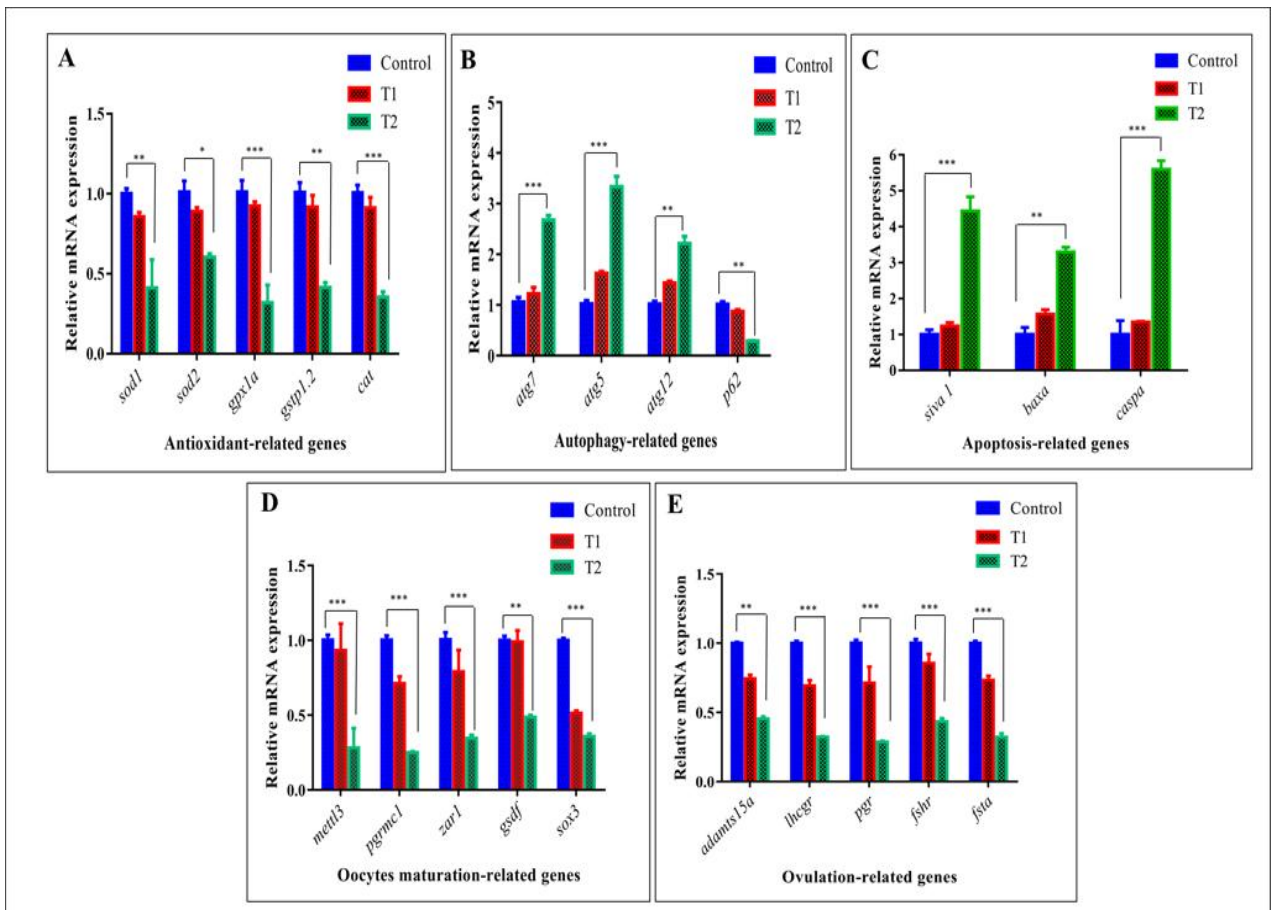
Figure 7. Effect of ZnO-NPs on oocyte maturation and ovulation via the induction of oxidative stress and the apoptotic pathway at the genetic level. ( A – C ) Expressions of mRNA evaluated by qRT-PCR indicate the downregulation of antioxidant-related genes in T2 ( A ), the upregulation of autophagy- related genes in T2 ( B ), and the induction of apoptosis-related genes in T2 ( C ). ( D , E ) mRNA expres- sion shows the downregulation of oocyte maturation-related genes in T2 ( D ) and ovulation genes in T2 ( E ). The results from three dependent experiments are shown as the mean ± SEM. * p < 0.05, ** p < 0.01, *** p < 0.001. T1 = group was exposed to 1/5th of the estimated LC50 of ZnO-NPs in water daily for two weeks (15 days). T2 = group was exposed to 1/5th of the estimated LC 50 of ZnO-NPs in water daily for one month (30 days).